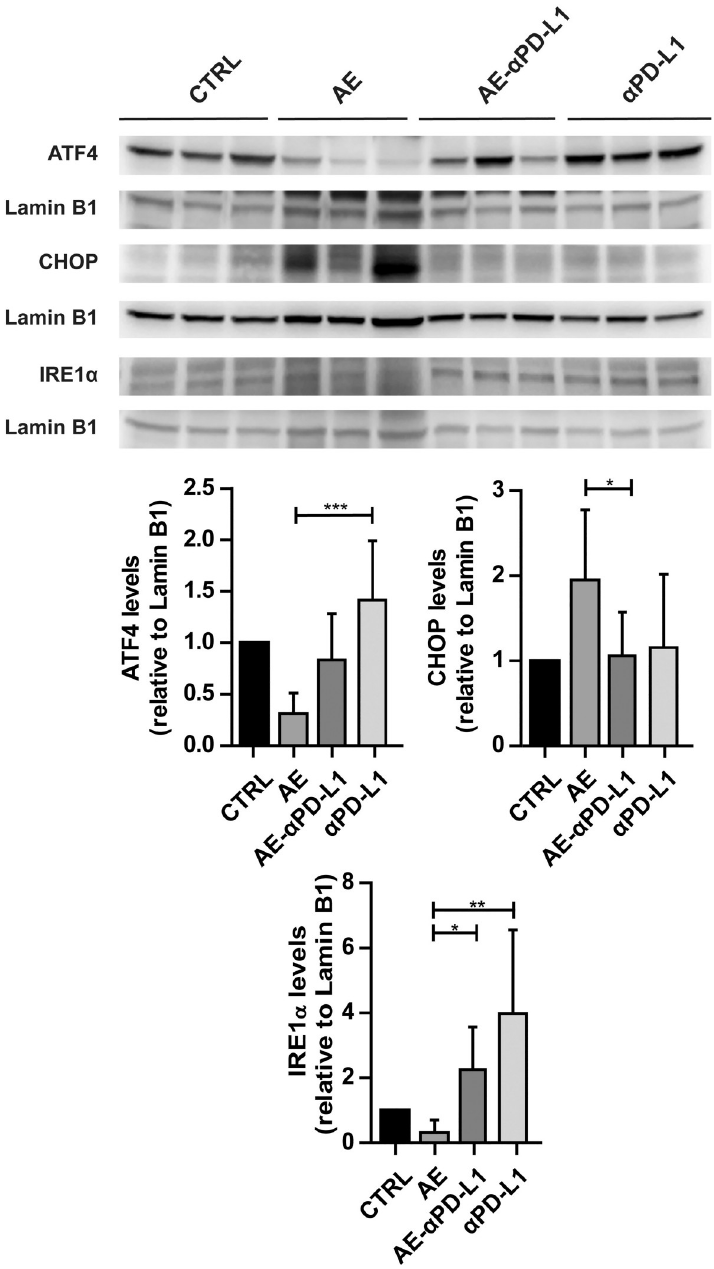
Fig 3. Effect of E . multilocularis infection and α PD-L1 treatment on the expression of proteins involved in UPR. Western blotting and semi-quantitative analysis by densitometry of protein levels of ATF4, CHOP, and IRE1 α in mock-infected control mice (CTRL), E . multilocularis infected mice (AE), infected mice treated with α PD-L1 (AE- α PD-L1) or uninfected mice treated with α PD-L1 ( α PD-L1) (animals per group n = 6). One representative blot (of two) containing samples from three different mice is shown. Lamin B1 served as loading control (animals per group n = 6). Densitometry results represent data from the two blots on samples from six mice (mean ± SD), normalized to Lamin B1 control and with CTRL set as 1. No outliers were detected/excluded. Non-parametric, Kruskal-Wallis test followed by Dunn’s Multiple Comparison post-test. � P � 0.05; �� p � 0.01; ��� p � 0.001.